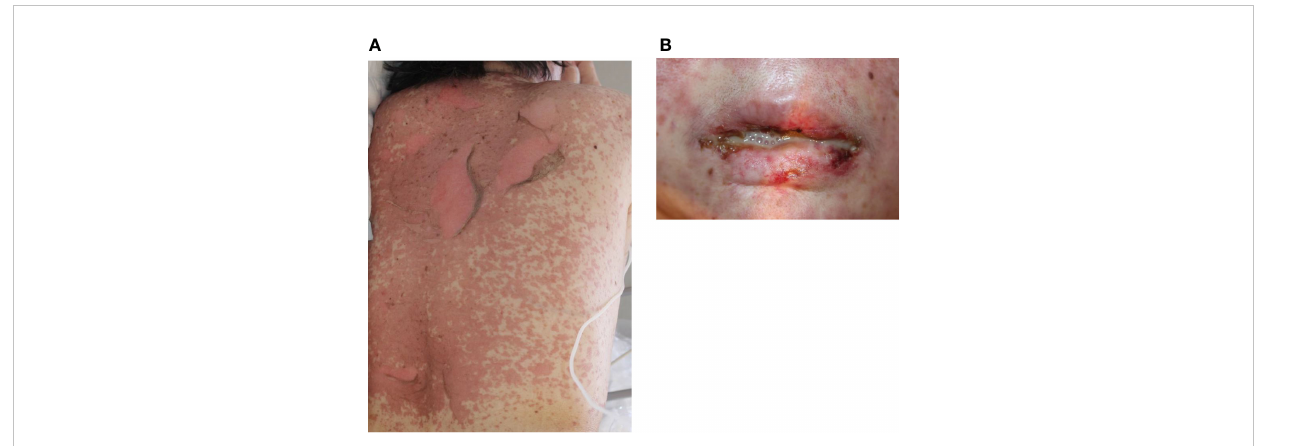
FIGURE 5 Toxic epidermal necrolysis. (A) Erythematous macules, bullae, and erosions on the trunk. (B) Hemorrhagic erosion of the lip. Written informed consent was obtained from the individual(s) for the publication of any identi fi able images or data included in this